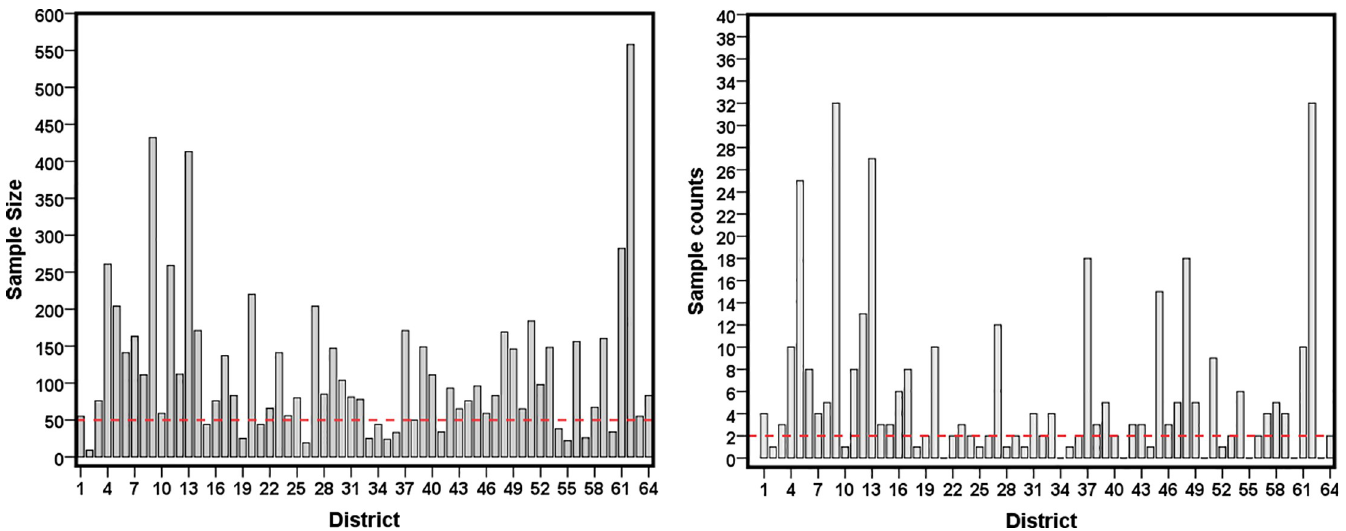
Fig 1. District-wise distribution of sample size (left hand side plot) and sample count (right hand side plot) in 2014 BDHS data.